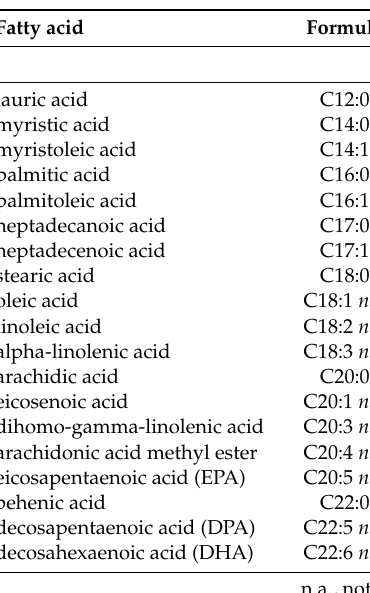
Table 1. Total fatty acid composition of native and micellar algae